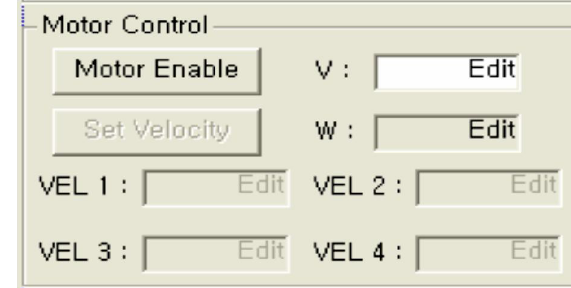
FIG. 25. COMPUTER SIMULATION WINDOW OF LASER RANGE FINDER